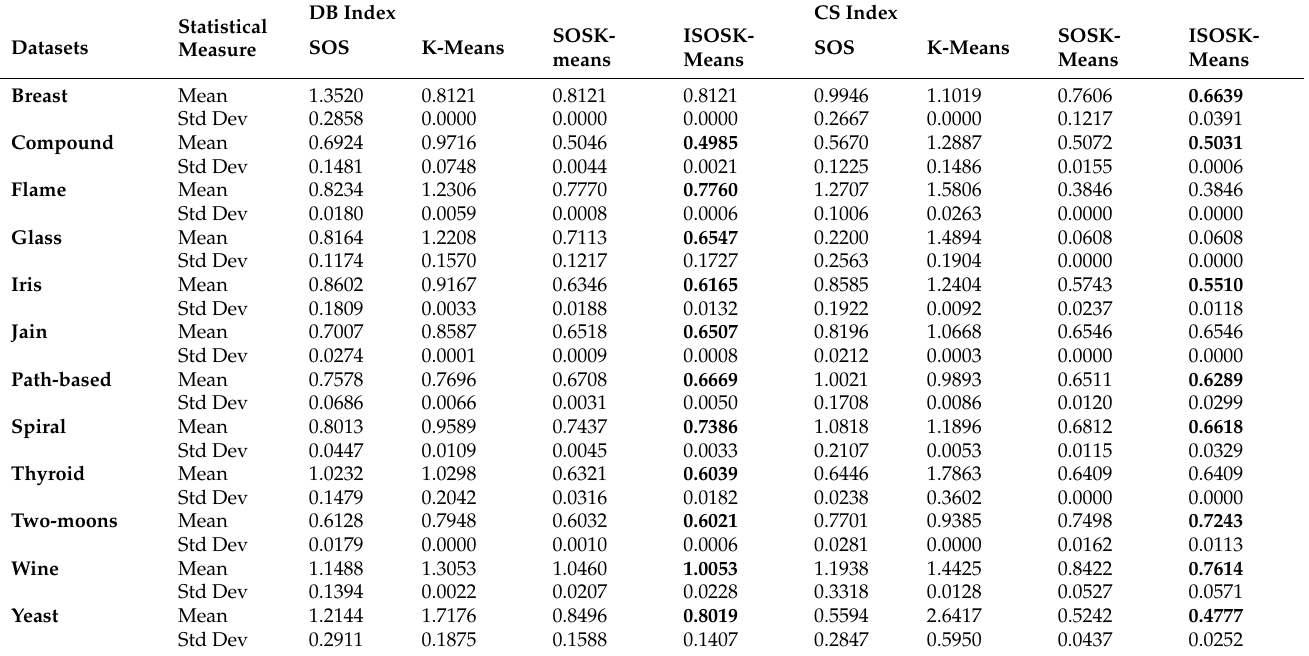
Table 5 summarizes the simulated results for each of the four competing algorithms for the automatic clustering of the 12 real-life datasets. The results present the mean and the standard deviation for each algorithm. The values were obtained for the two cluster validity indices, the DB index, and the CS index. Table 5. Computation results for the four competing algorithms on 12 real-life